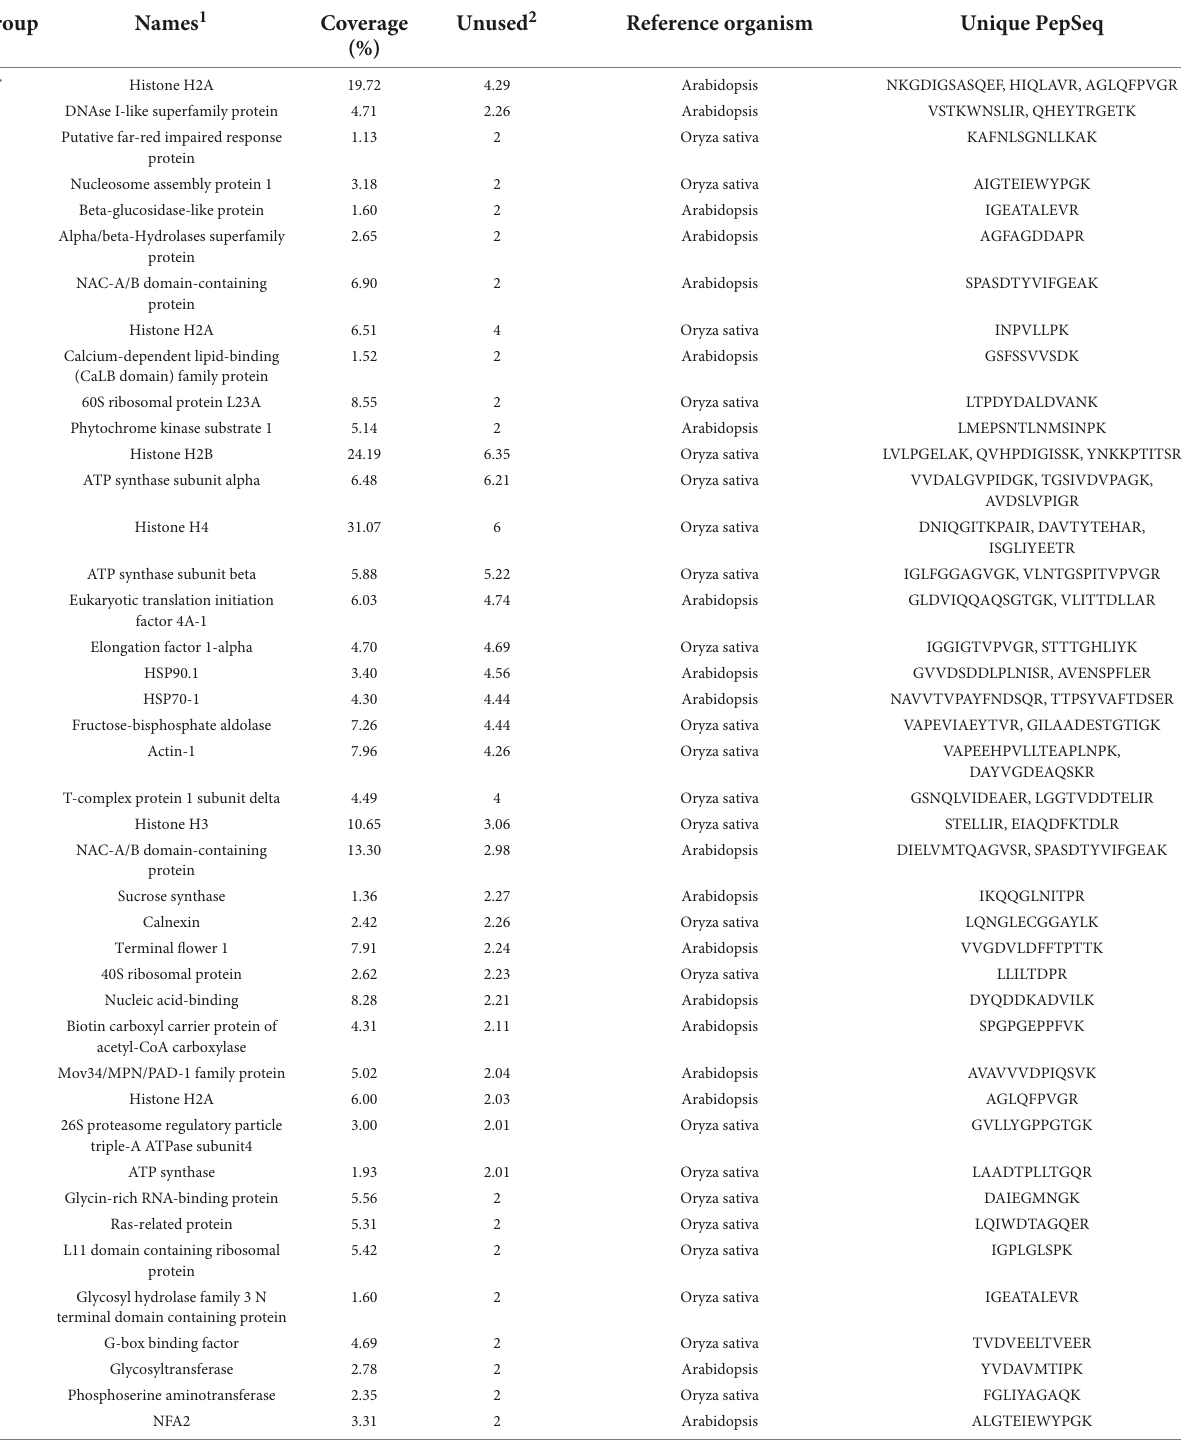
TABLE 2 Proteins from DNA-pulldown were identified by